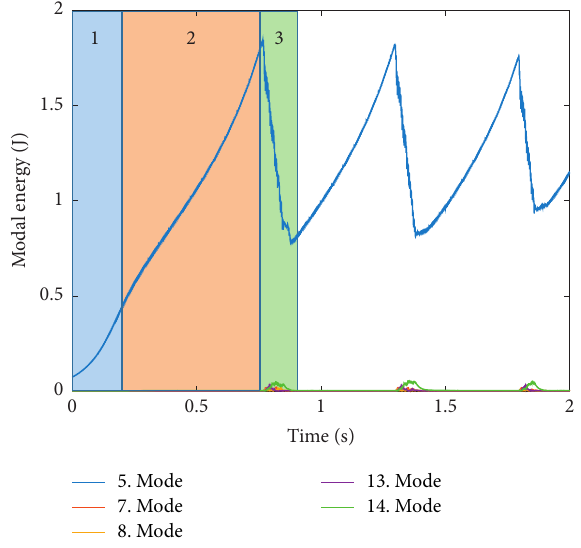
Figure 6: Modal energies of the five modes with the highest modal energy in the shock